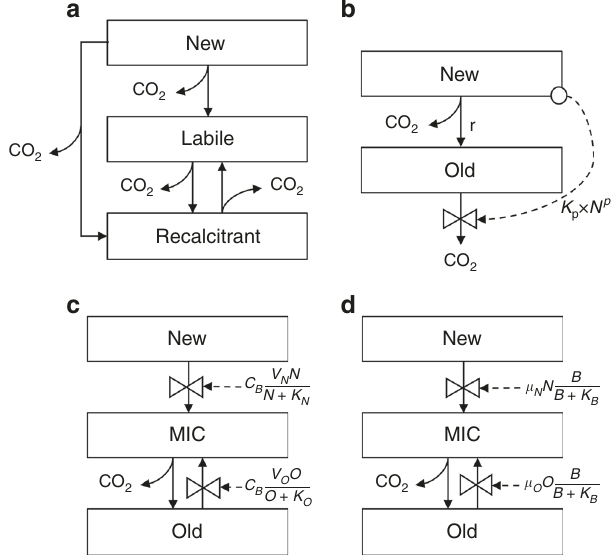
Fig. 1 Schemes of four soil C dynamic models. a Conventional model; b Interactive model; c Michaelis – Menten model; d Reverse